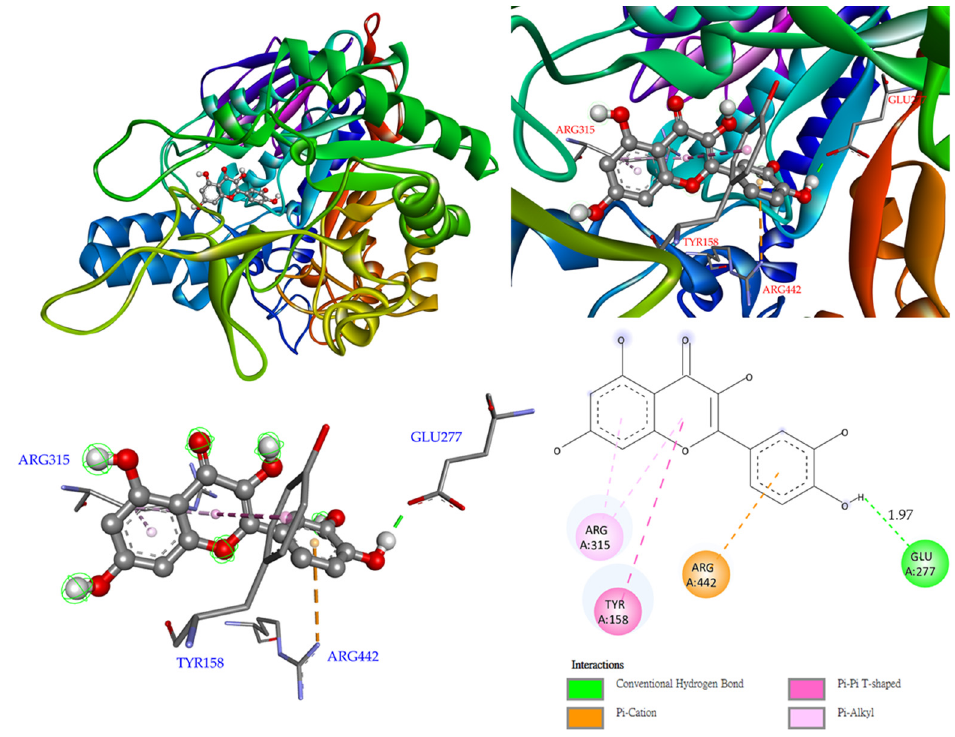
Figure 7. Interactions of quercetin ( 4 ) with active sites of S. cerevisiae α -glucosidase. Finally, compound 5 was bound with Arg 315 and Leu 313 via conventional hydrogen bonds, while other interactions (alkyl and π –alkyl) were also perceived with Arg 442, Phe 303, and Lys 156 (Figure 8).